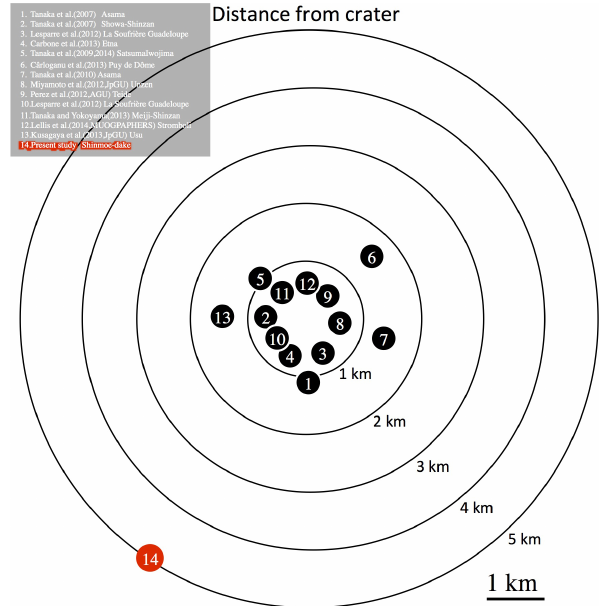
Figure 1. Visual comparison with prior works. The past muogra- phy observation sites are plotted as distance from the peak of the